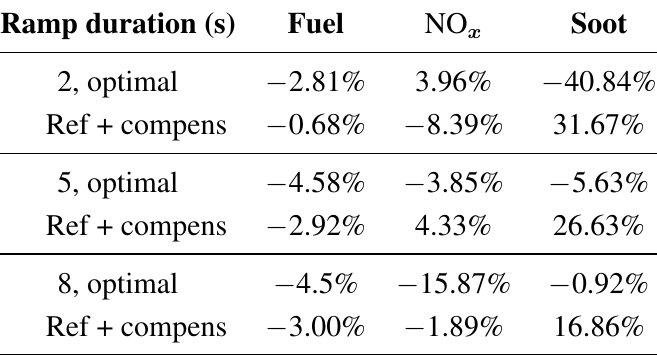
Table 5. Effect of the implementation of the compensation maps, for three cases representing very fast, fast and medium ramps. Comparison to optimal TB control, in terms of relative change with respect to reference